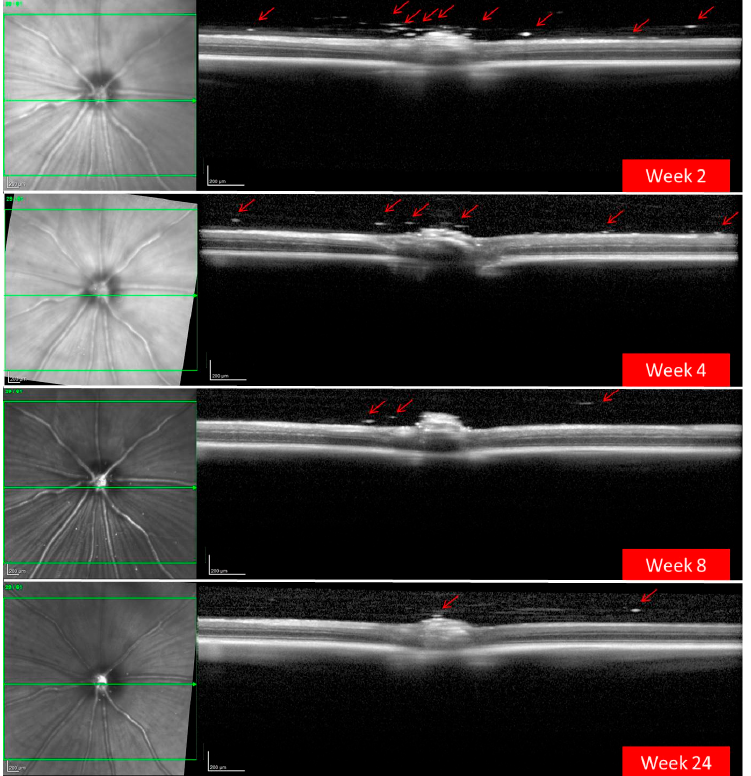
Figure 3. Progressive decrease in hyper-reflective aggregates (red arrows) of the brimonidine– Laponite intravitreal formulation (BRI/LAP IF) detected in the vitreous–retinal interface using optical coherence tomography over 24 weeks of follow-up.